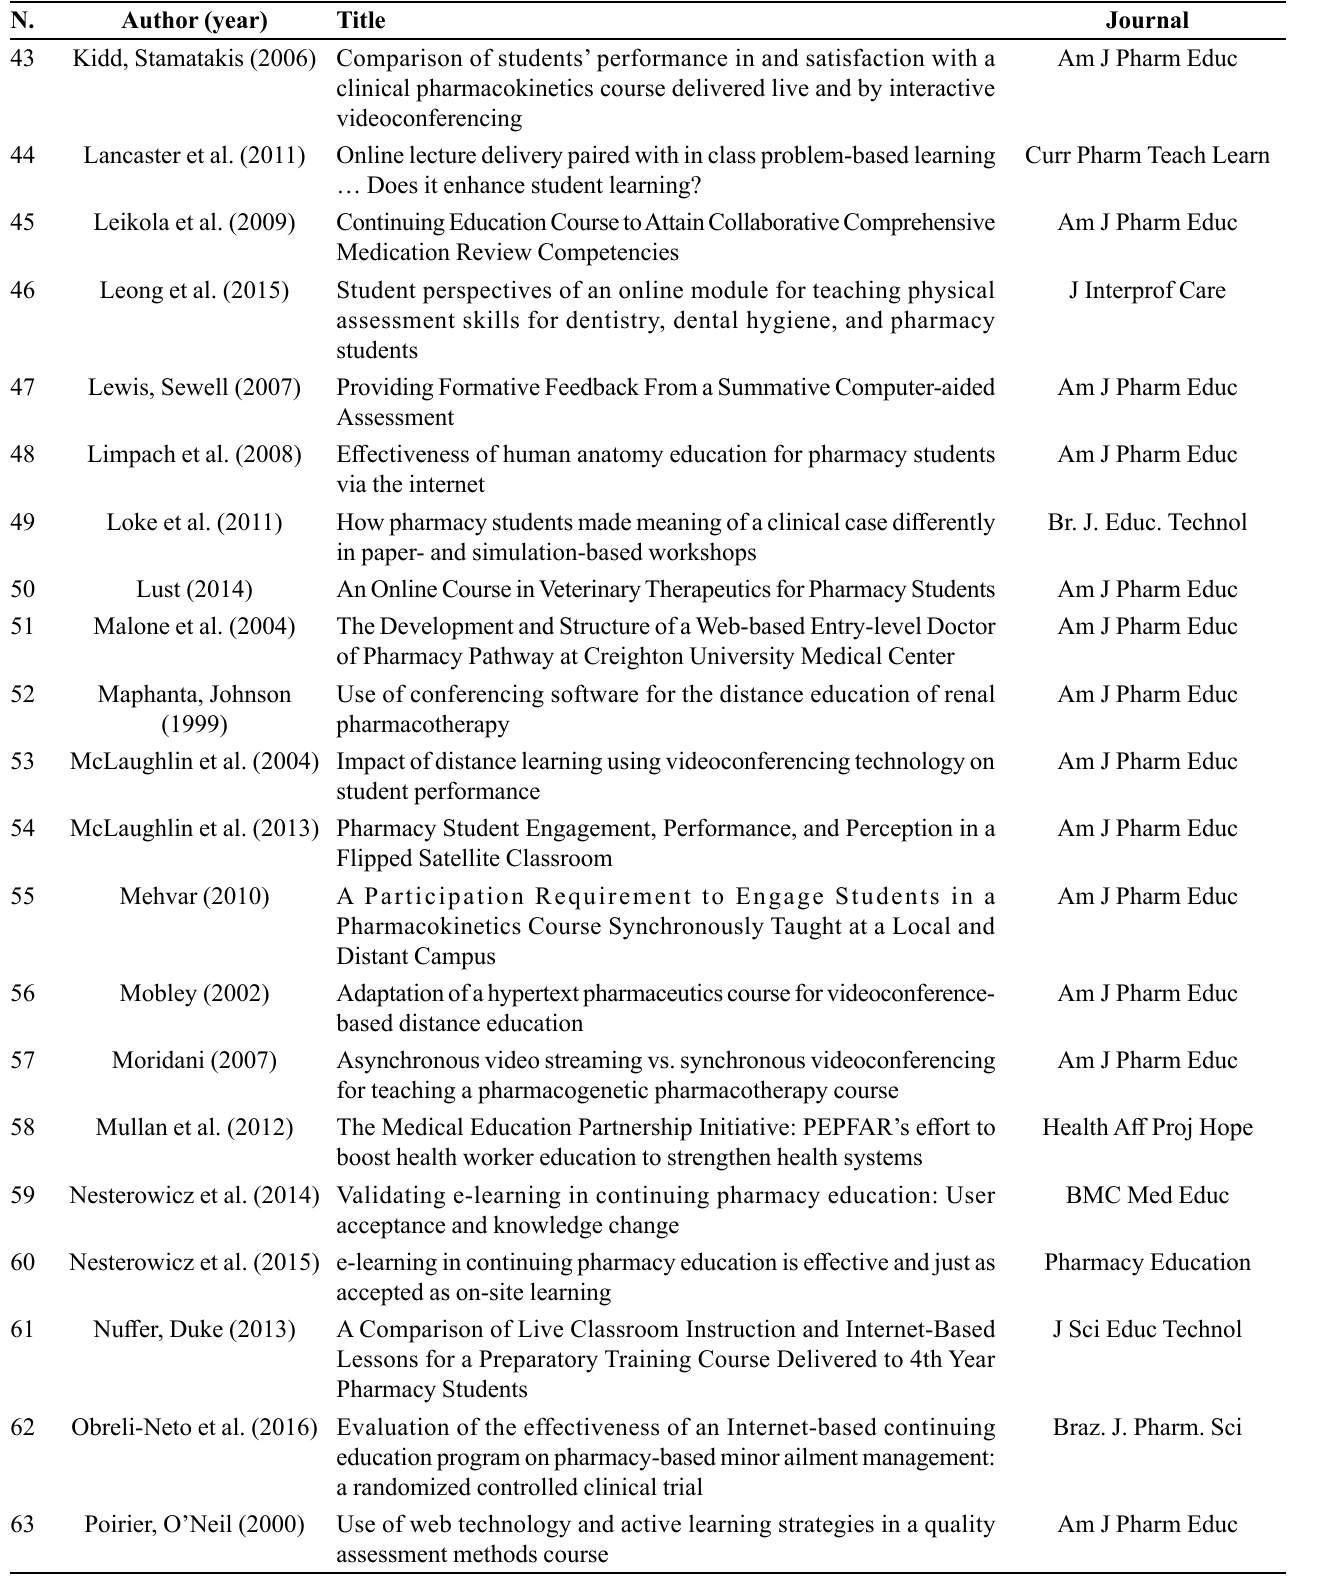
TABLE II - Selected articles for review study